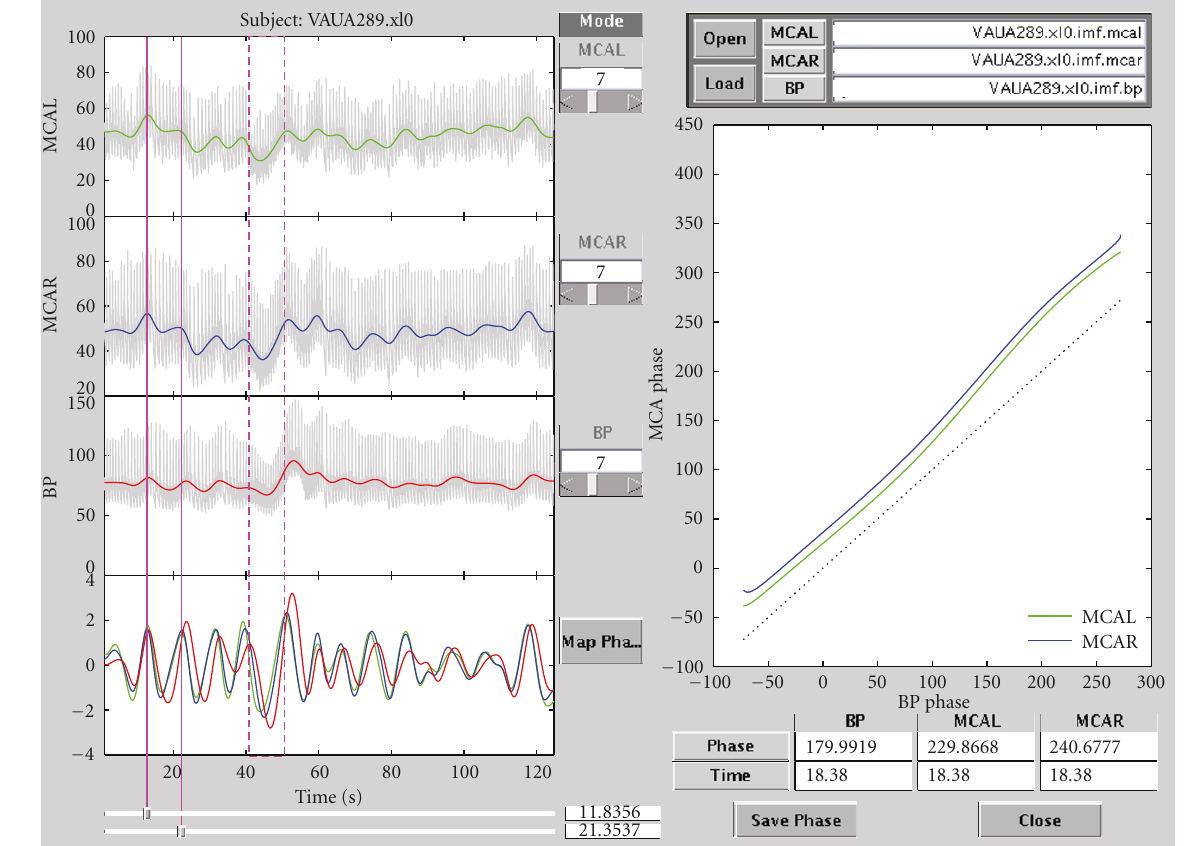
Figure 4: Screen copy of the MMPF analysis software (adapted from [15]). The data shown in this plot are from a healthy subject. The top three panels on the left show BFV (left side and right side) and BP signals, respectively. The colored curves in these panels show the results after removing faster fluctuations from the original signals. The bottom left panel shows the corresponding intrinsic modes for these three signals (red: BP; blue: BFV on right side; green: BFV on left side). The vertical red dashed box (around 40–50 seconds) identifies part of the VM period. The spontaneous oscillations in these signals during resting conditions prior to the VM can also be visualized. One of these oscillations (around 14–22 seconds) is identified by two vertical red lines. The result of the BP-BFV phase shift analysis of this period is plotted in the right panel. A reference line (dotted black line), indicating synchronization between BP and BFV, is shown in this panel for easy comparison. The result is representative of normal autoregulation where BFV leads BP (by about 50 degrees in